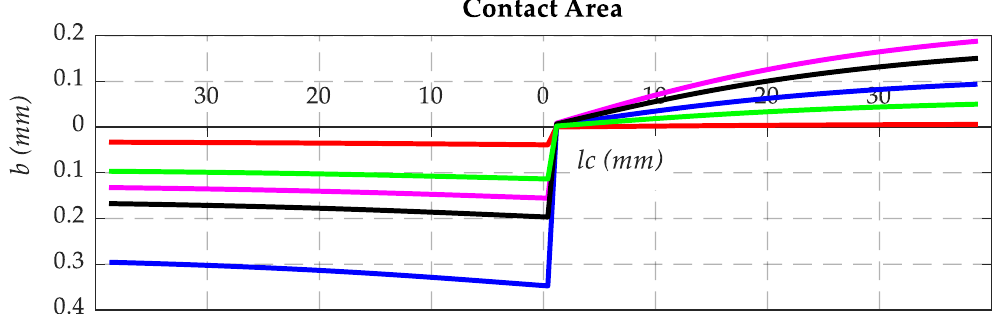
Figure 3. Contact width ( b ) over workpiece contact length ( l c ).